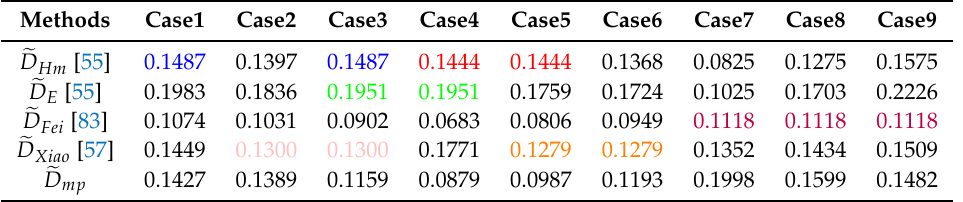
Table 2. The comparison of different methods’ results.